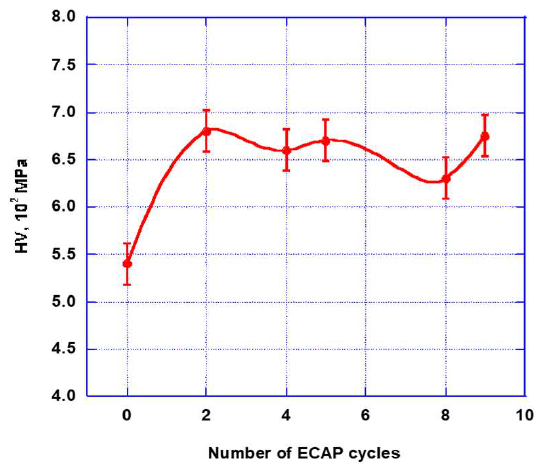
Figure 9. Microhardness of the AZ31 alloy vs the increasing number of ECAP passes at 200 °C.